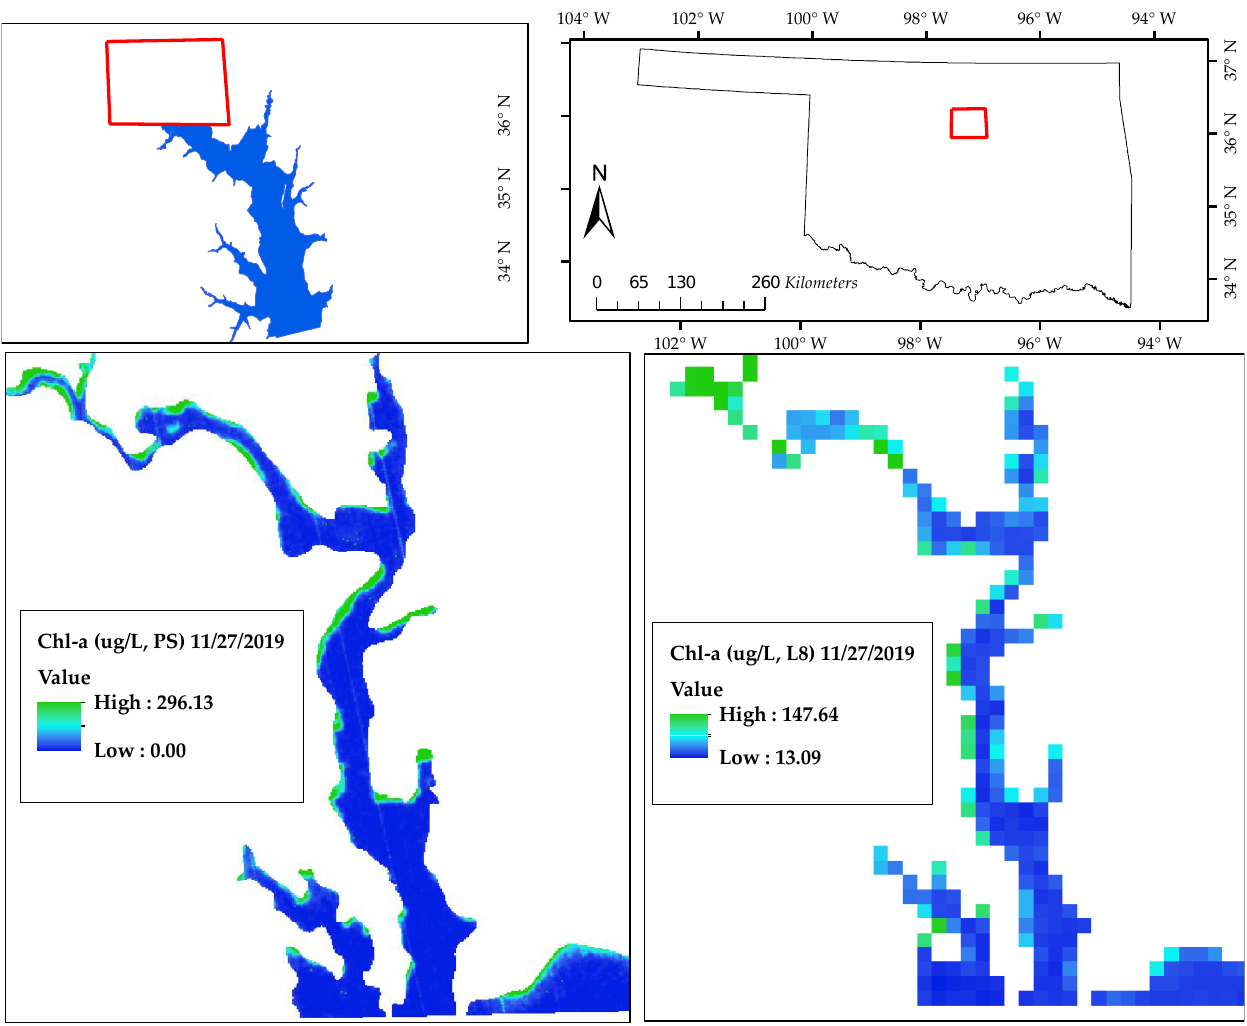
Figure 7. PS ( Left ) and Landsat-8 ( Right ) maps of Chl-a in Lake McMurtry, northcentral Oklahoma. Both satellites acquired their images on 27 November 2019, during an active algal bloom event. The overview maps at the top show the location of Lake McMurtry in Oklahoma (Top Right spec in a red box) and Lake McMurtry (Top Left) showing the focus area delineated in a red box. The color bars represent concentration ranges as estimated by each of the two satellites.